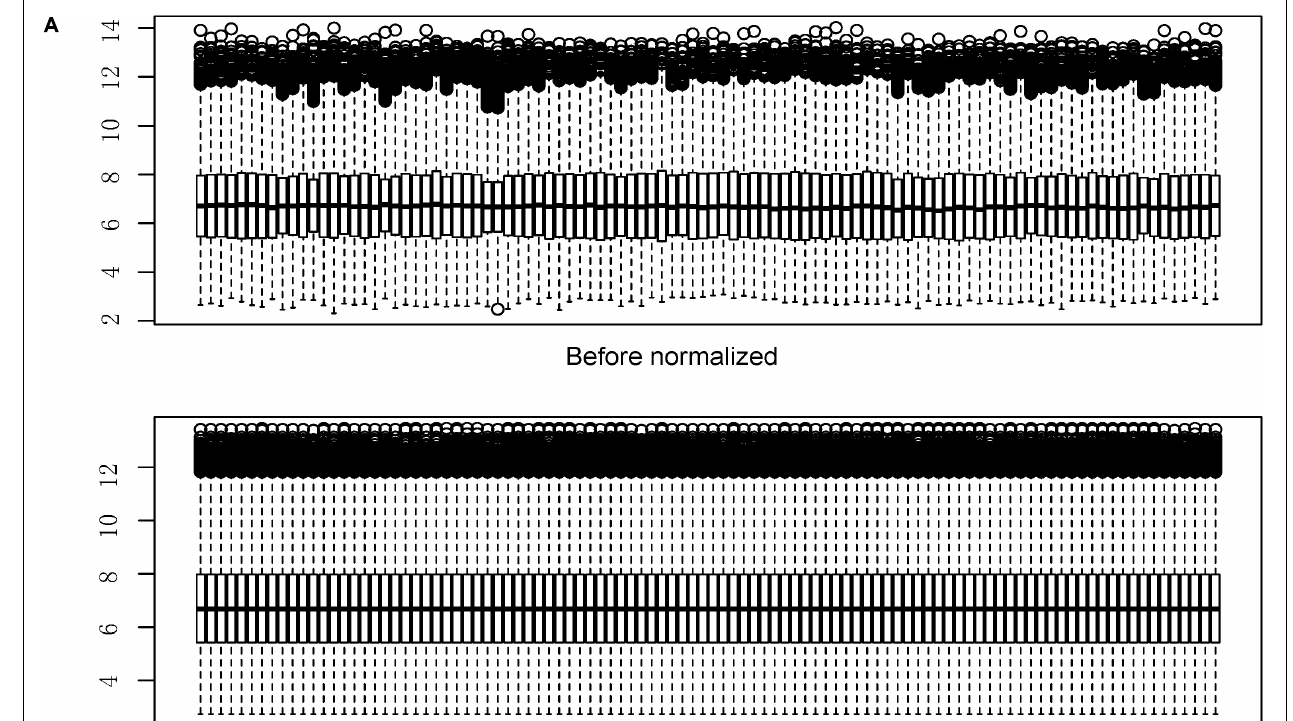
FIGURE 2 | Data normalization and sample clustering dendrogram. (A) Data were normalized using the limma package of the R software. (B) Sample clustering was performed using the Pearson’s correlation matrices and the average linkage method.